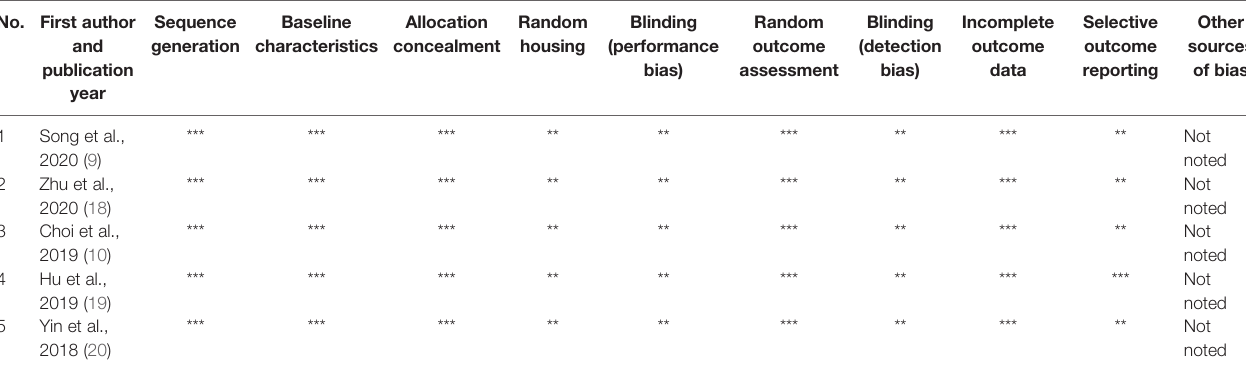
TABLE 4 | Evaluating the potential risk of bias in the included in vivo